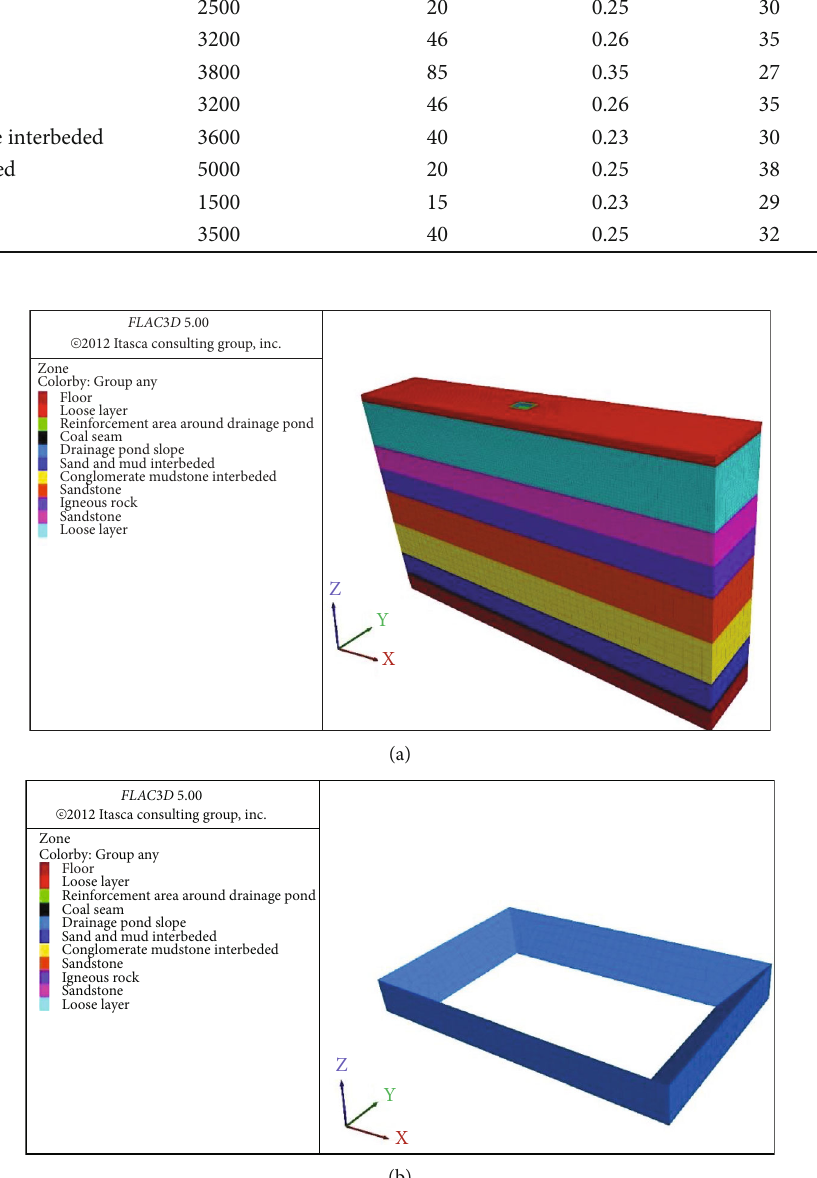
Figure 3: Numerical calculation model of mining subsidence: (a) overall model of mining subsidence; (b) numerical model of boat pond.